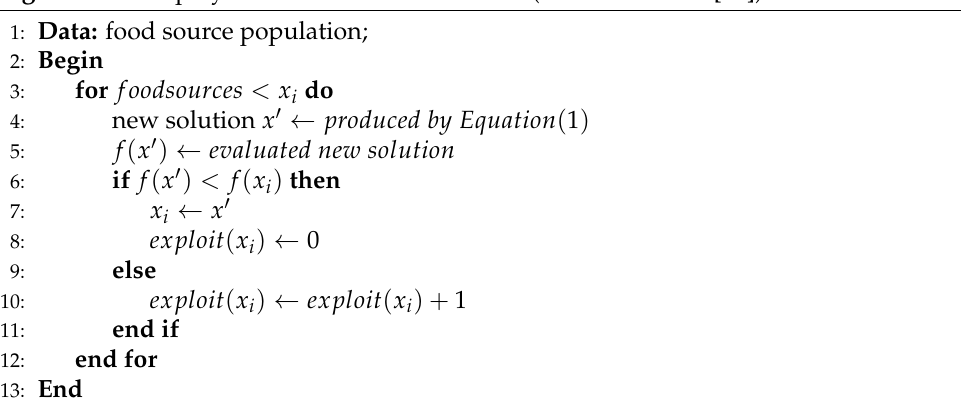
Algorithm 2 Employed Bees’ Labor Pseudocode (Modified from